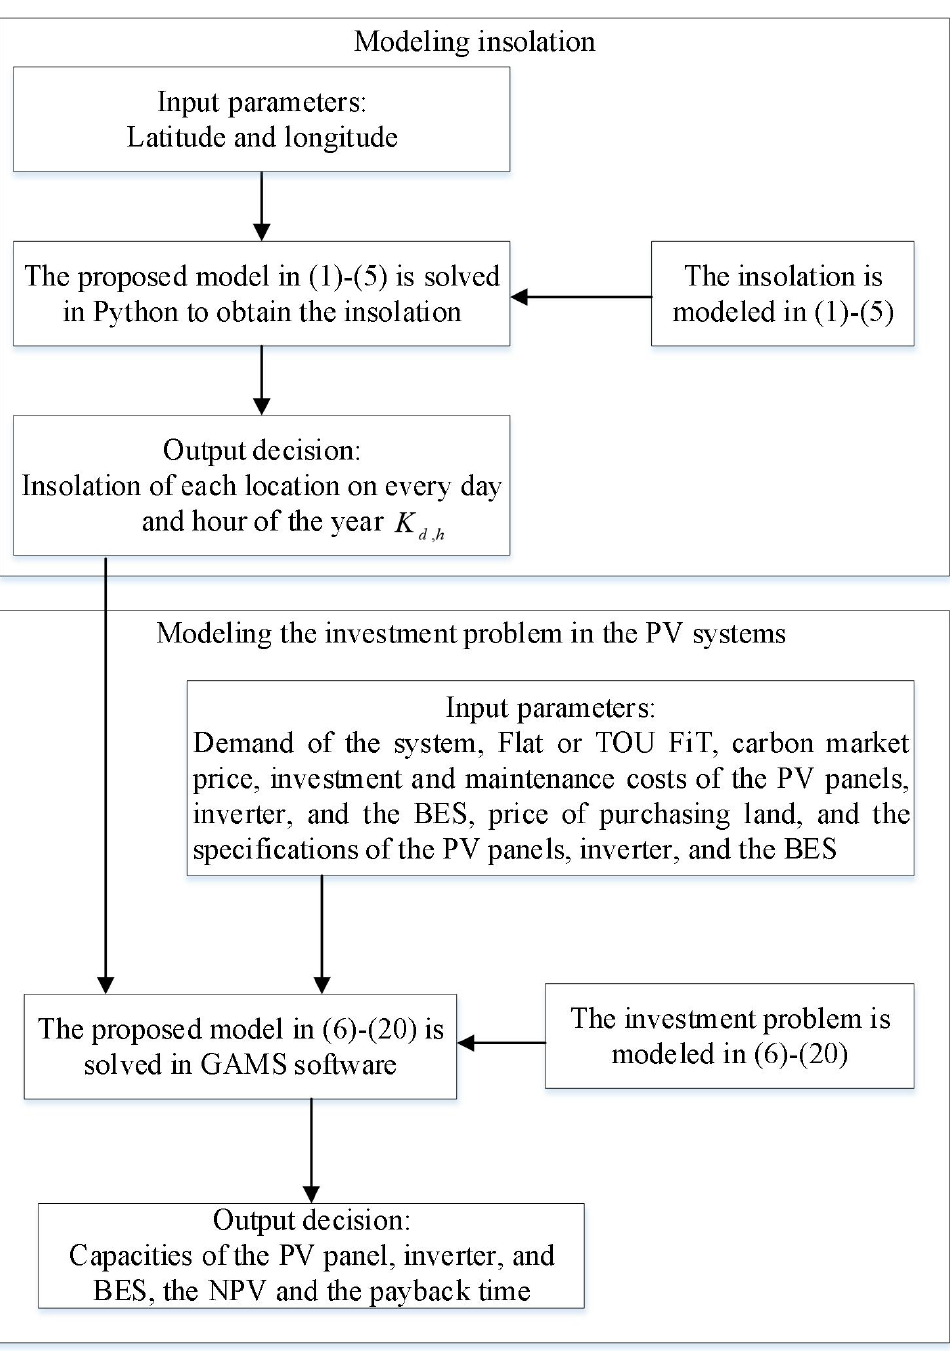
Figure 1. The proposed approach in this paper for modeling the investment problem in PV systems.